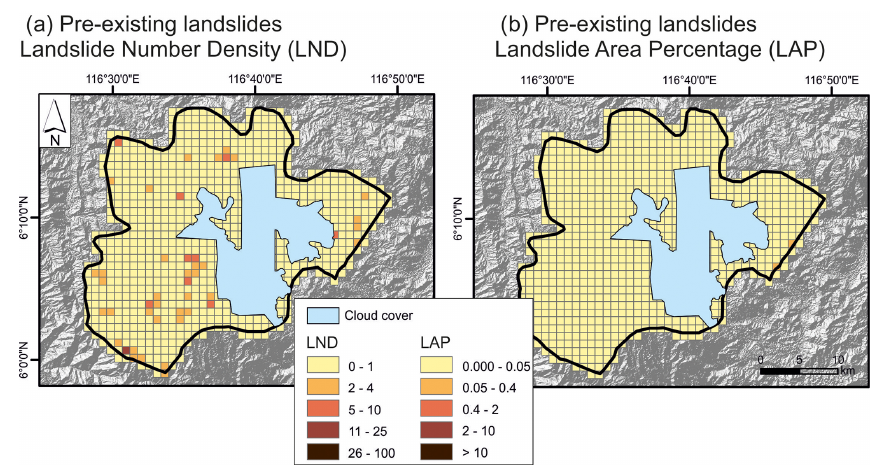
Figure 6. Grid maps of landslide number density (LND, a ) and landslide area percentage (LAP, b ) for pre-existing landslides; the blue area represents a region where cloud-free pre-earthquake imagery is lacking. Color map follows Crameri et al.